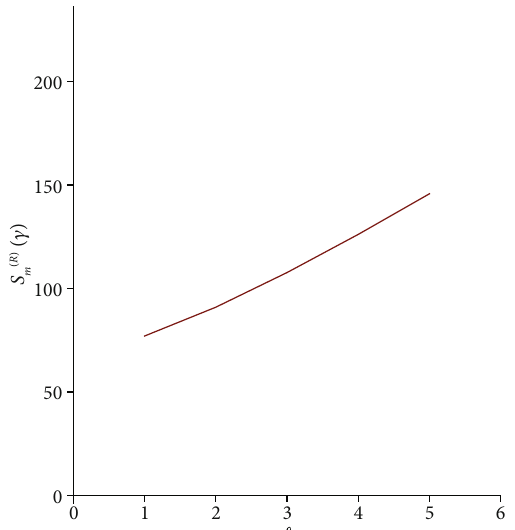
Figure 12: Contribution of the angular momentum quantum number ℓ to the Tsallis entropy for the momentum space S ð T Þ m ð γ Þ with μ = c = ℏ = 1 , Η = 20 , T = 10 , and ϱ = σ = 0 : 1 for D = 3